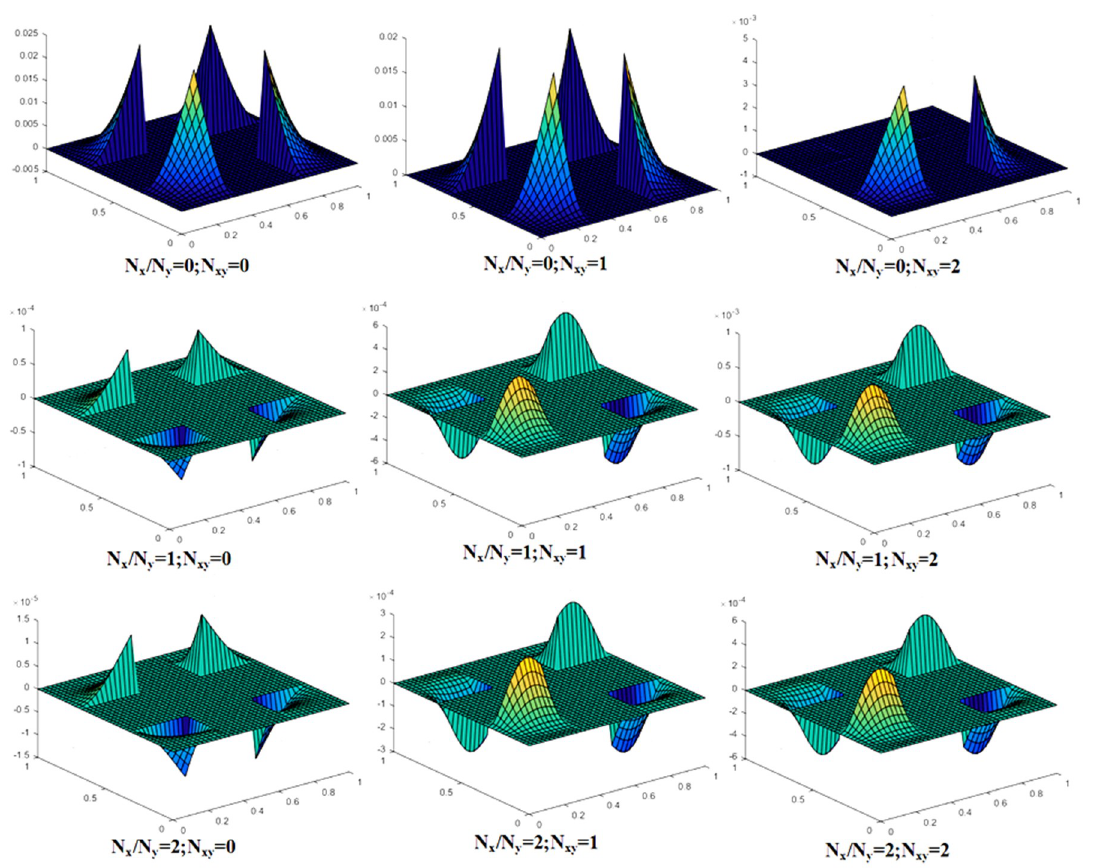
Figure 7. Mode shape for a laminated composite plate with lamination scheme A, a / h = 100, cutout size 0.4a and CCCC boundary condition.